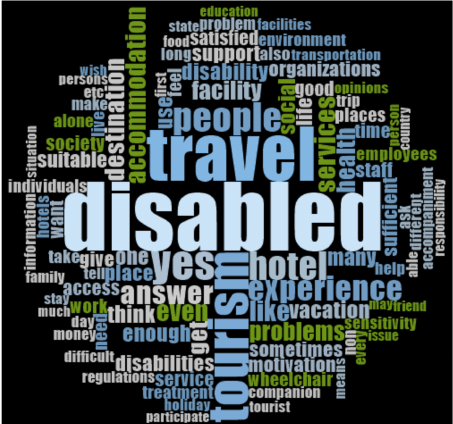
Figure 8. Computer software NVivo program was used for structuring the qualitative research conducted, analyzing the findings in an organized way and detailing frequently used keywords under